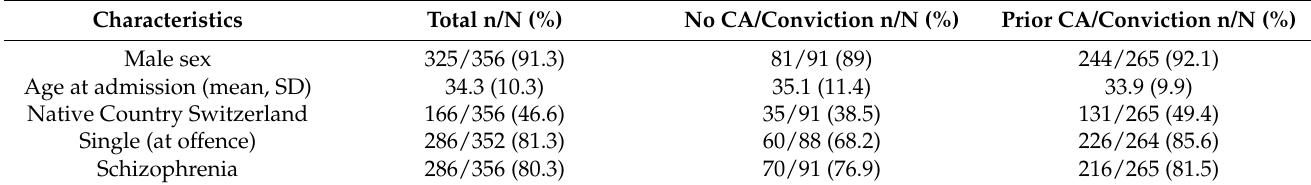
Table 1. Sociodemographic